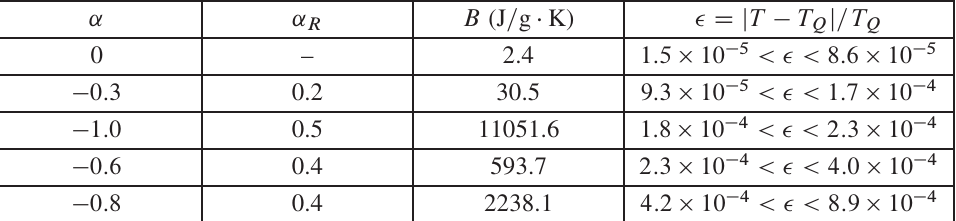
D 0:1 (Table 1), ˛ D 0:1 (Table 2) and ˛ D 0:1 (Ta- ˛ R ble 4) are very close to the Ising model value. Also,